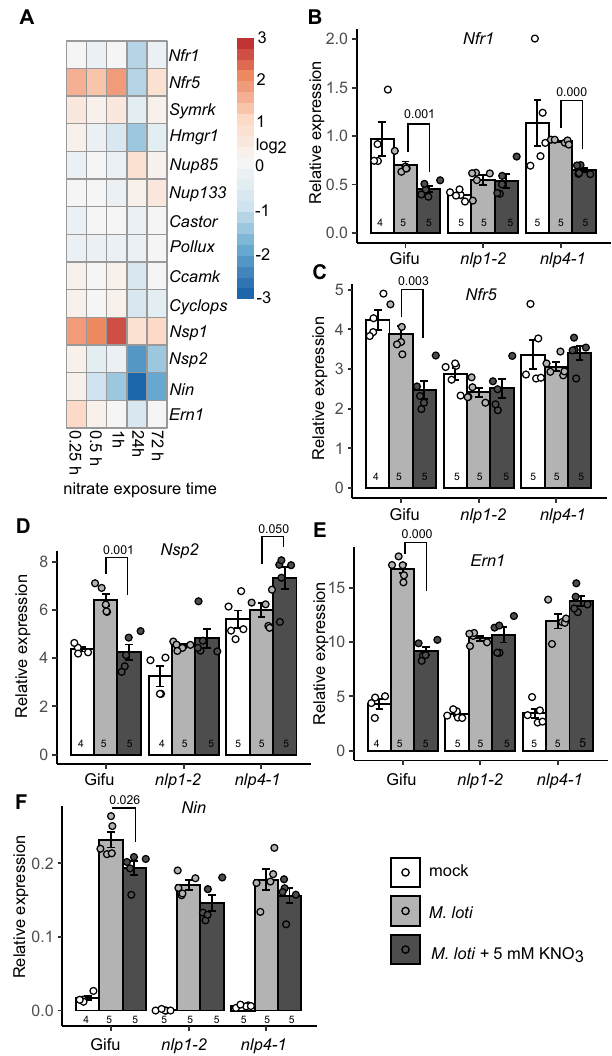
Fig. 8 Nitrate inhibits symbiotic signalling via Nlp1 and Nlp4 . A A heatmap of NF signalling gene expression at different times following nitrate exposure. B – E Relative transcript abundance of Nfr1 ( B ), Nfr5 ( C ), Nsp2 ( D ), Ern1 ( E ) and Nin ( F ) by qRT-PCR 1 dpi with M. loti in the absence and presence of 5 mM KNO 3 in the indicated plant genotypes. Ubiquitin is used as a reference gene. Bars show mean ± SE for for the indicated n values. Signi fi cant differences between nitrate presence and absence conditions is annotated with P values as determined by Student ’ s t test. Gene IDs and expression values are shown in Supplementary Table